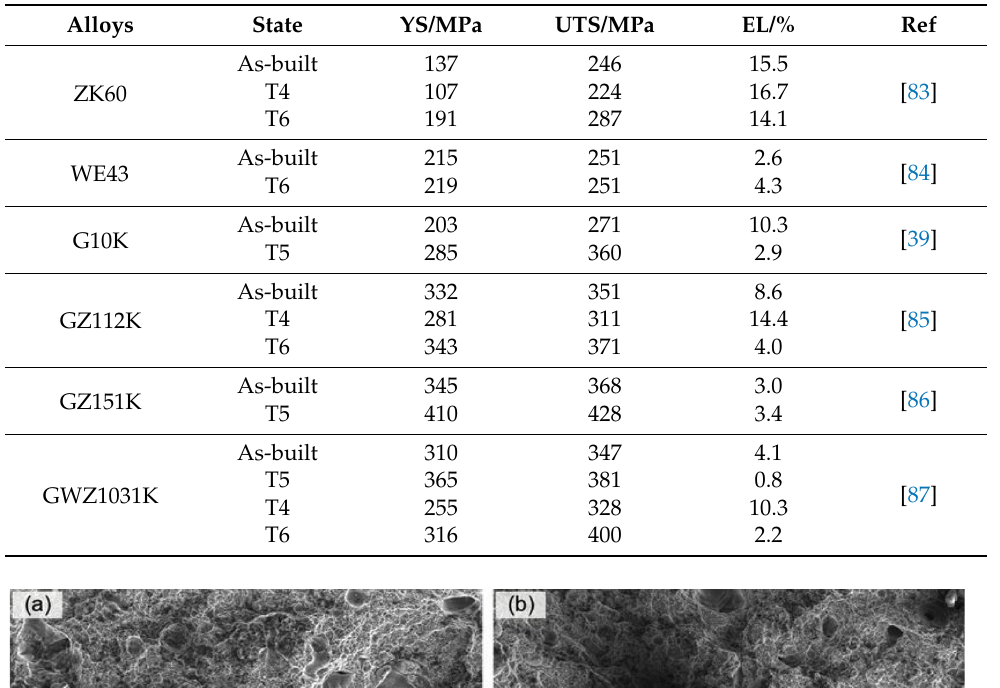
Table 2. The tensile properties of the as-built and post-processed Mg alloys fabricated by SLM under optimized process parameters.